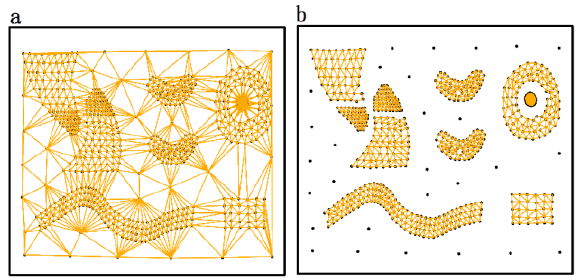
Figure 8. Construction of spatial proximity relationships of S 1: ( a ) Delaunay triangulation of S 1; and ( b ) Modified Delaunay triangulation of S 1. ISPRS Int. J. Geo-Inf. 2016 , 5 , 205 11 of 18